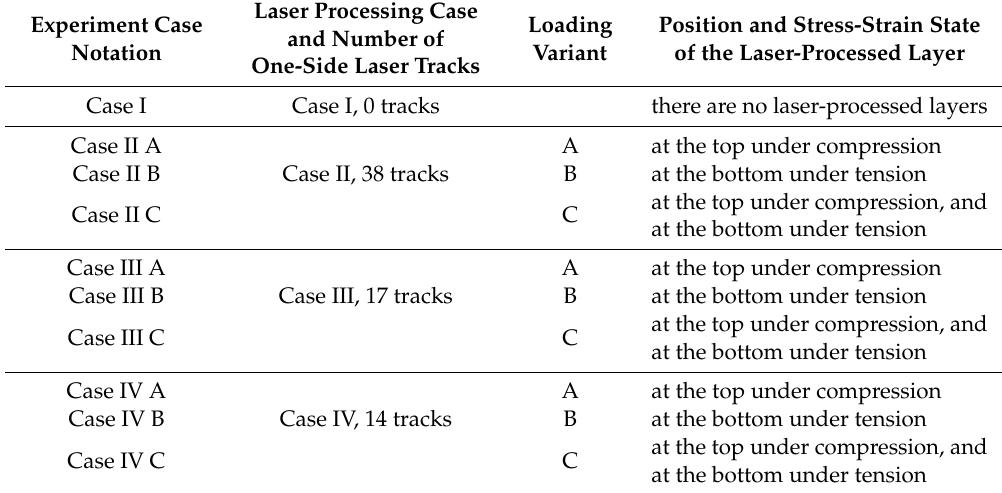
Table 5. Force–deflection experiment